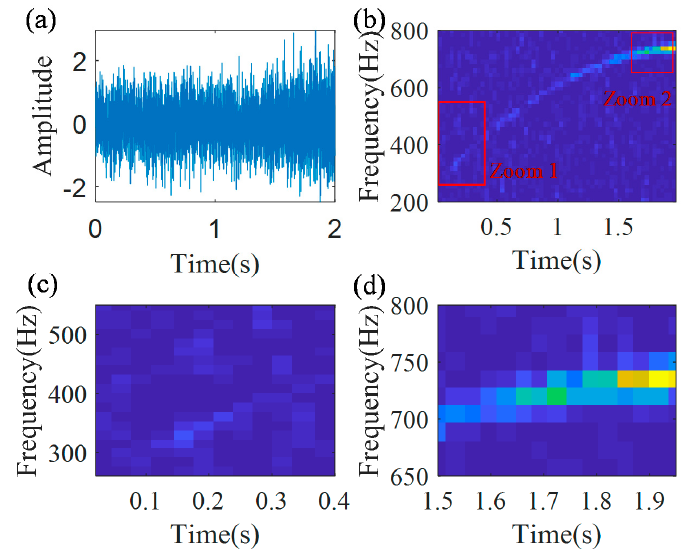
Figure 4. TFR: ( a ) envelope signal; ( b ) TFR; ( c ) local zoom 1; and ( d ) local zoom 2.